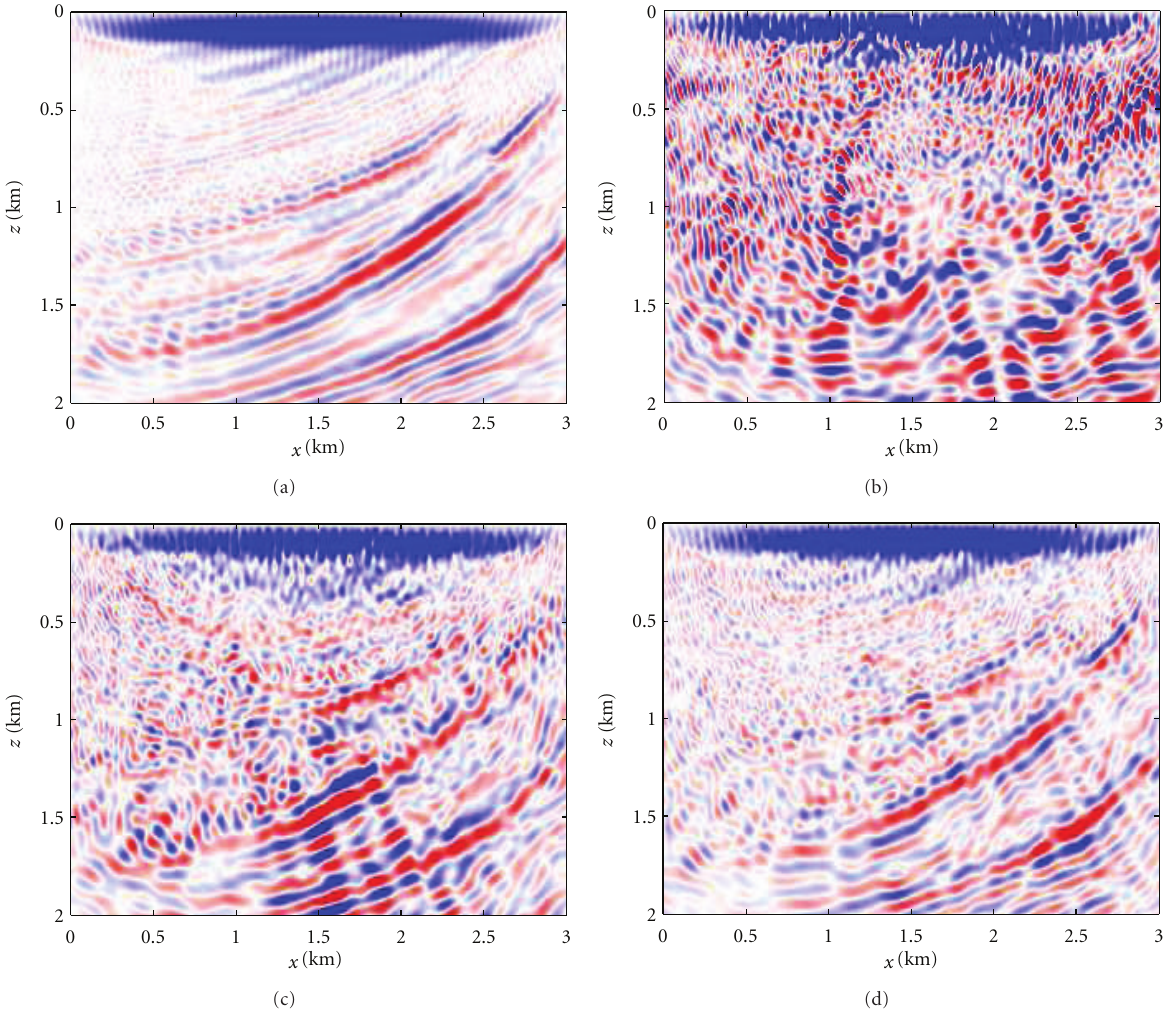
Figure 2: The full gradient is depicted in (a). The approximate gradients for various K are depicted in (b) K = 1, (c) K = 5, and (d) K = 10. For a relatively small batch size, the approximate gradients already show the main